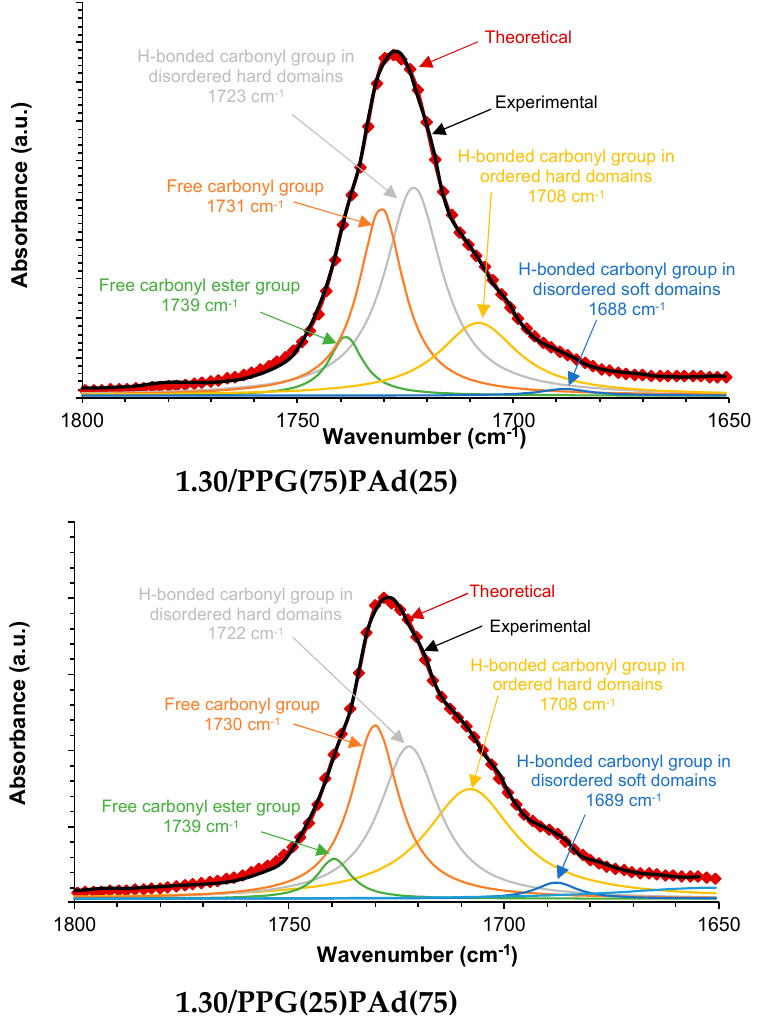
Figure A1. Curve fitting of the carbonyl region of the ATR-IR spectra of 1.30/PPG(75)PAd(25) and 1.30/PPG(25)PAd(75). The term “theoretical” was used to describe the curve fitted spectra by using Gaussian function.